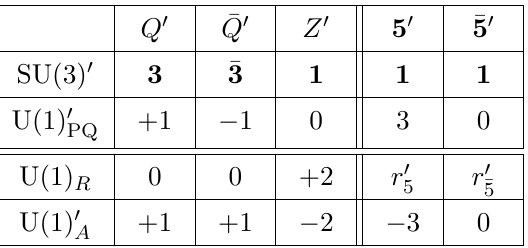
Table 2 . Charge assignment of the dynamical PQ symmetry breaking sector. The chiral super(cid:12)elds, Q 0 ’s, and Z 0 ’s, are the SU(3) 0 triplets and singlets, respectively. The U(1) 0 to U(1) B symmetry in the SU(3) 0 sector. The KSVZ extra multiplets are denoted by 5 0 and (cid:22) 5 0